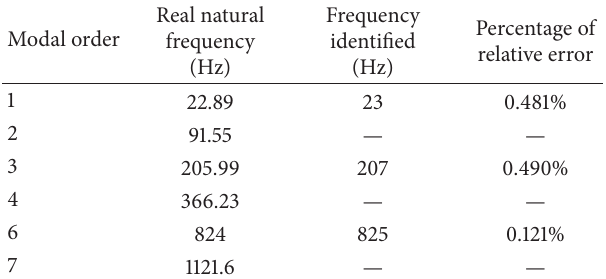
Table 13: Error of natural frequencies identified by maximization kurtosis with gradient descent method.